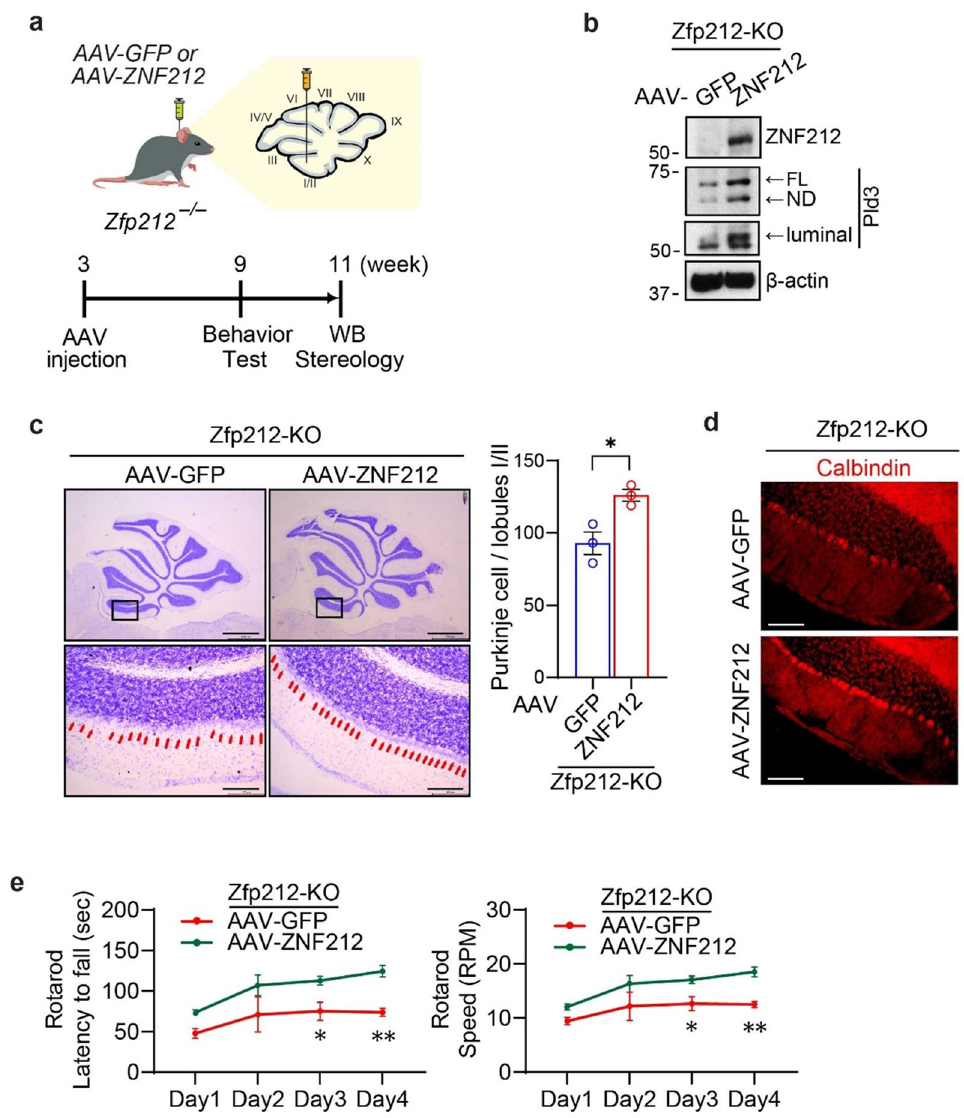
Figure 5. Delivery of human ZNF212 rescues Purkinje cell death and aberrant locomotion in Zfp212-KO mice. ( a ) Stereotaxic administration of AAV-GFP and AAV-ZNF212 into the cerebellum (lobule I/II) of 3-week- old Zfp212-KO mice. Behavioral tests and further analyses were performed at the indicated time points. ( b ) Overexpression of human ZNF212 in the cerebellum of Zfp212-KO mice was confirmed by immunoblot analysis. Expression was normalized to β-actin (bottom panel, n = 3). ( c ) Representative image of Nissl staining in the cerebellum of AAV-GFP and AAV-ZNF212 injected in Zfp212-KO mice 8 weeks post-injection. Scale bars = 1000 μm at the original image and 100 μm at the enlarged image, respectively. ( d ) Calbindin staining of the cerebellum of Zfp212-KO mice injected with AAV-GFP or AAV-ZNF212 at 8 weeks post-injection. Scale bars = 100 μm. ( e ) Rotarod test of Zfp212-KO mice injected with AAV-GFP or AAV-ZNF212 (AAV-GFP; n = 4, AAV-ZNF212; n =